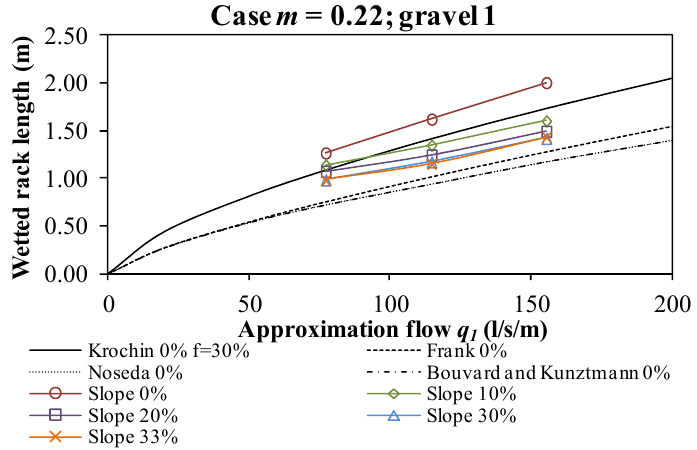
Figure 13. Wetted rack length of rack B calculated for each inlet flow rate, different rack slopes and gravel 1.